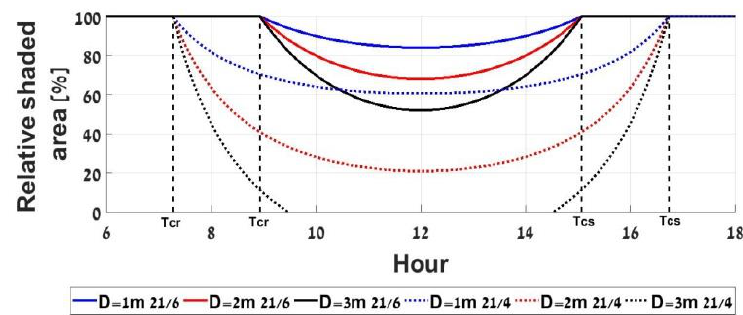
Figure 12. Daily variation of percentage shaded area on the bottom collector on April ( ... ) and June (___) 21st, H = 0.941 m , D = 1.0, 2.0, 3.0 m . The relative shaded area, in percentage, on the ground cast by an overhang roof of a carport is depicted in Figure 13. The roof is of a long edge and the overhang width is H = 5.0 m . The figure shows the daily variation of the relative shaded area on April 21st (dotted lines) and on June 21st (solid lines), for two distances D = 3.0, 5.0 m . At noon hours in summer months, the solar rays still penetrate the parking area, and in winter months the parking area enjoys the sun.